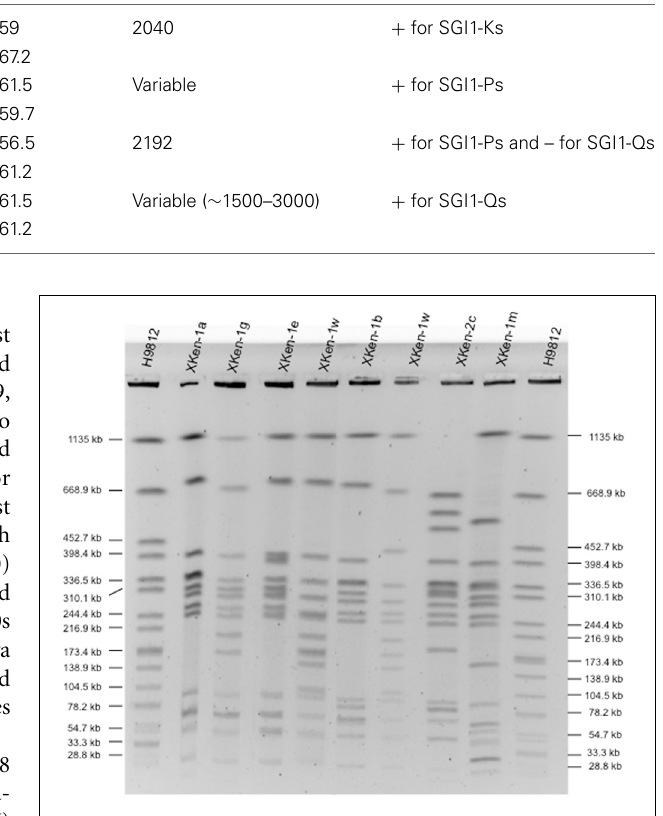
FIGURE 1 | Representatives of Xba I-PFGE profiles obtained among S. enterica serotype Kentucky isolates from humans and nonhumans during the period